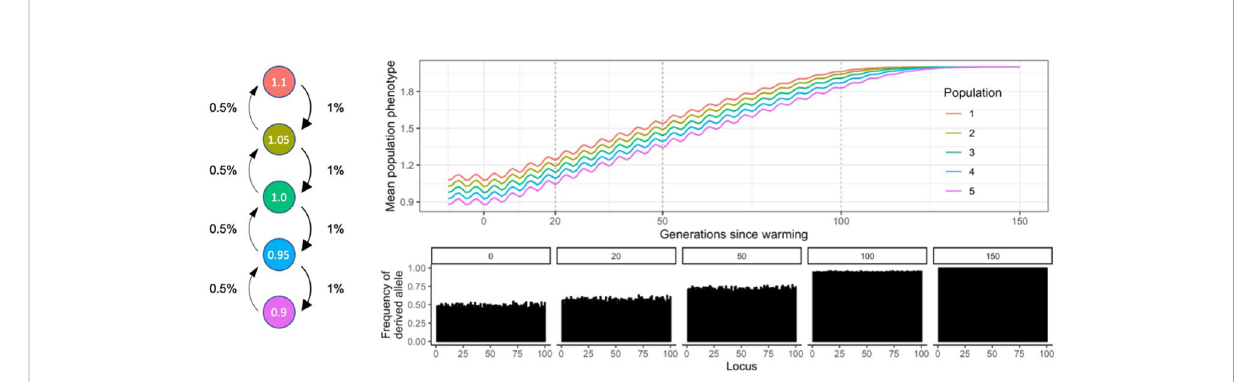
FIGURE 1 Diagram of metapopulation structure including migratation rates, environmental conditions and allele frequencies at sampling timepoints of the SLiM model discussed in this